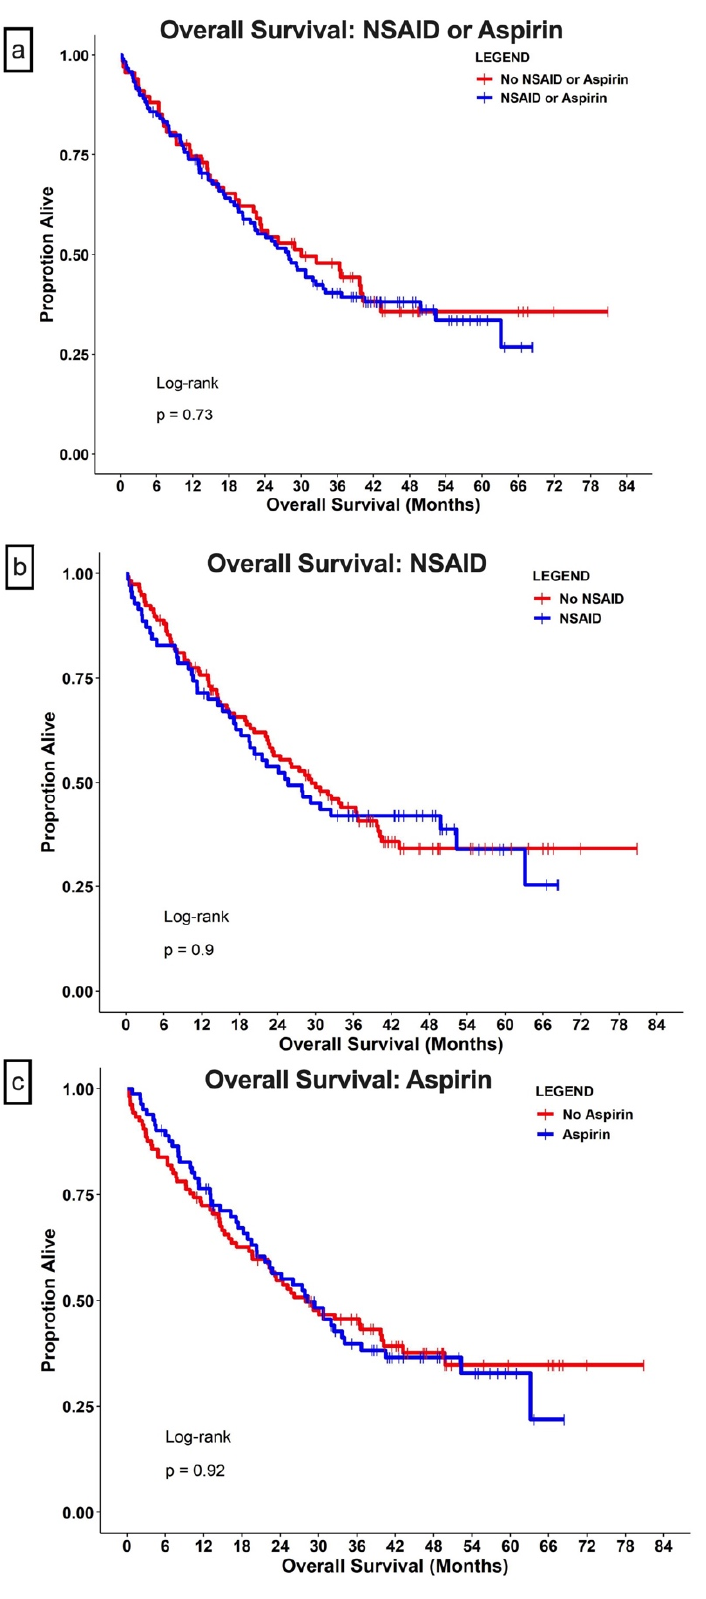
Figure 2. Overall survival. Patients with metastatic renal cell carcinoma were grouped based on concurrent use of ( a ) COX inhibitors (aspirin or NSAID); ( b ) use of aspirin; or ( c ) use of NSAIDs. The dots in all panels indicate censored data.